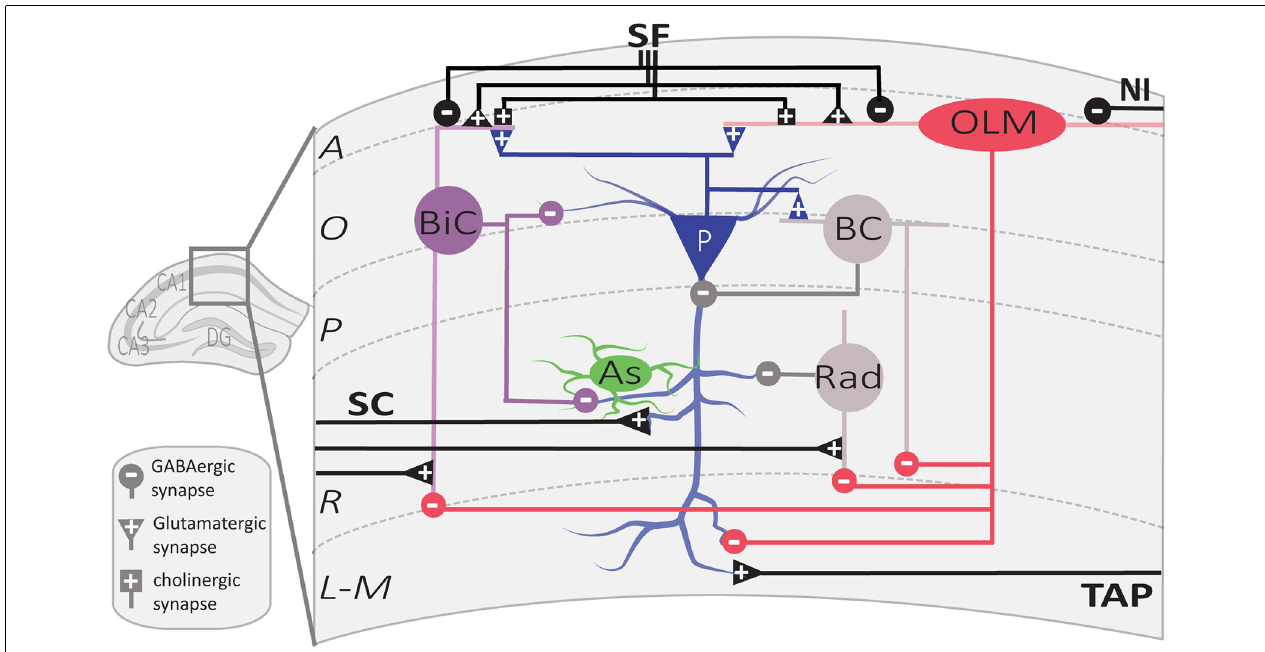
FIGURE 2 | Local circuit of CA1 SOM interneurons. Simplified diagram illustrating the local synaptic circuits of OLM cells and BiCs with other cell types in dorsal CA1 hippocampus. Abbreviations for CA1 layers: A, alveus ; O, oriens ; P, pyramidale ; R, radiatum ; L-M, lacunosum-moleculare. Abbreviations for CA1 afferent inputs: SF, septal fibers; NI, nucleus incertus fibers; SC, Schaffer collateral pathway from CA3 pyramidal cells; TAP, temporo-ammonic pathway from entorhinal cortex. Abbreviations for SOM cell types: (red) OLM, oriens/lacunosum-moleculare cell; (violet) BiC, bistratified cell. Abbreviations for other cell types: (blue) P, pyramidal cell; (gray) BC, basket cell; (green) As, astrocyte; (gray) Rad, unidentified stratum radiatum interneurons targeted by OLM